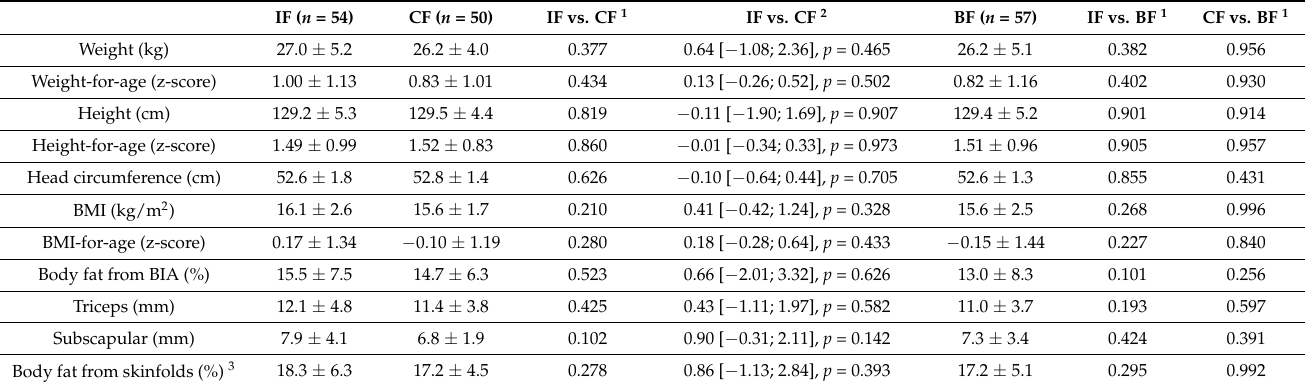
Table 2. Anthropometry and body composition at the age of seven years (mean ± SD) for the interventional formula group (IF), control formula group (CF) and formerly breastfed infants (BF).